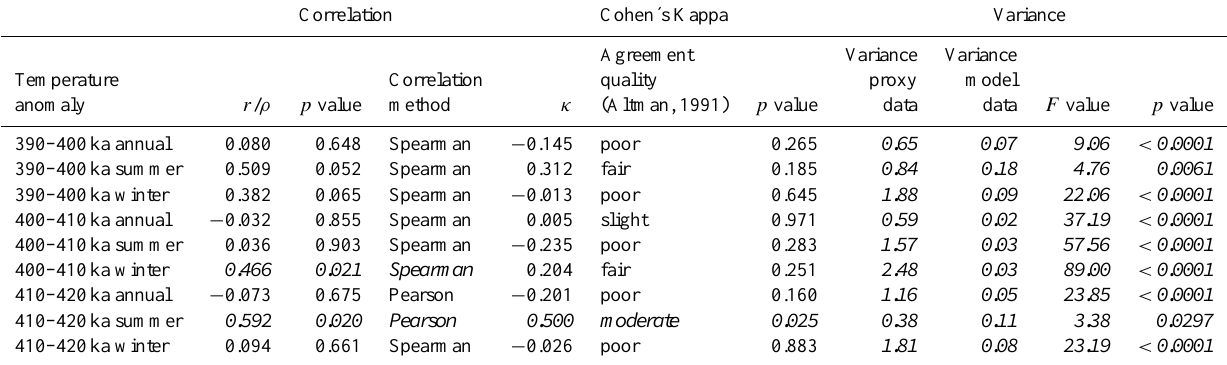
Table 4. Correlation coefficients and Cohen’s κ values between the proxy and model SST anomalies for the three MIS11 time slices (Fig. 7), as well as a comparison of variances in the proxy and model data (statistically significant values are given in